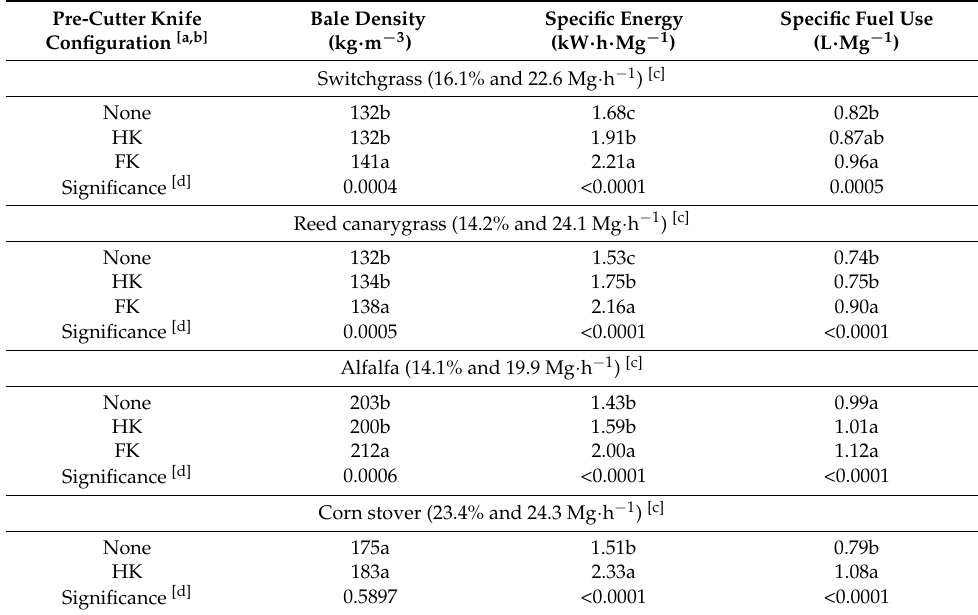
Table 6. Large round bale density and specific energy and fuel use (all on a dry basis) as affected by pre-cutting (LRBr exprs. nos. 1–3, Table